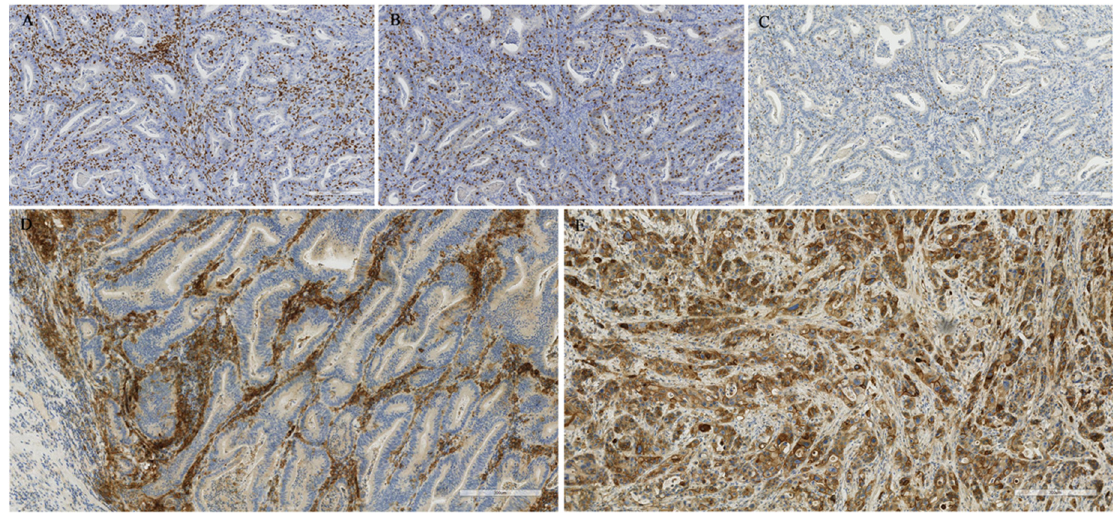
Figure 2. Examples of CD3 ( A ), CD8 ( B ) and PD ‐ 1 ( C ) stainings. ( D ) PD ‐ L1 positive staining in immune cells and ( E ) PD ‐ L1 positive staining in tumour cells. Images were captured with 8× zoom from 20× magnified scanned slides.